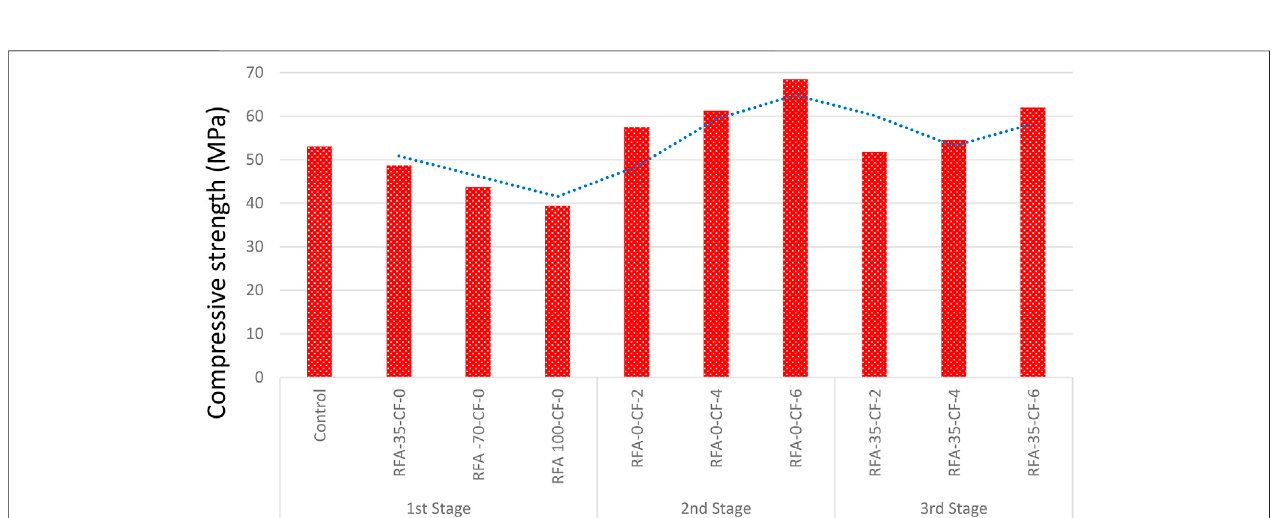
FIGURE 4 | Results of Slump test.